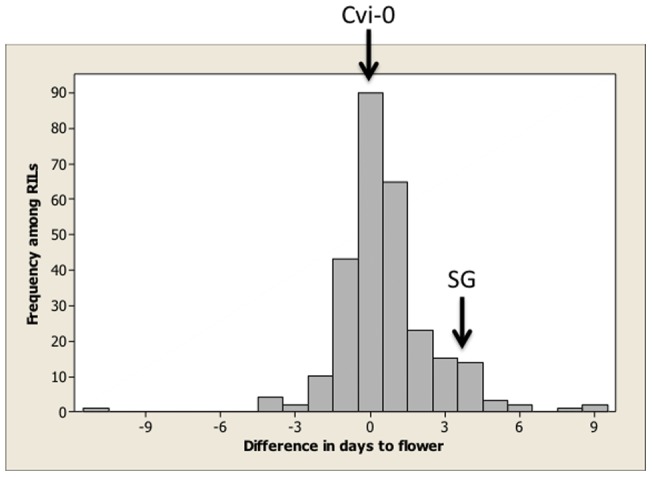
Frequency distribution of RIL responses for flowering time.The x-axis was calculated as days to flower at 700 ppm [CO2] minus days to flower 380 ppm [CO2]. Thus, positive values represent delays in flowering at elevated [CO2] and negative values represent more rapid flowering (with 0 being no change in flowering time due to [CO2]). Differences for parental Cvi-0 and SG are shown with arrows.